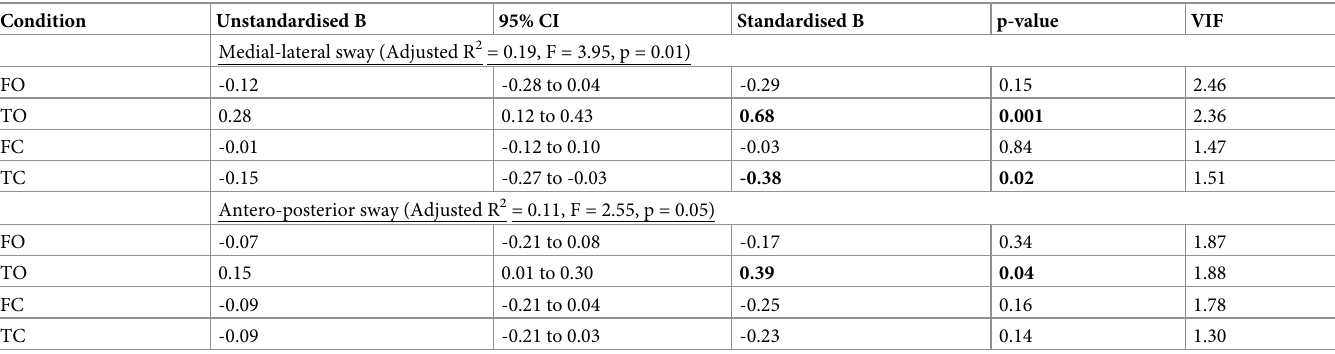
Table 2. Results of multiple linear regressions for static balance measures. Condition Unstandardised